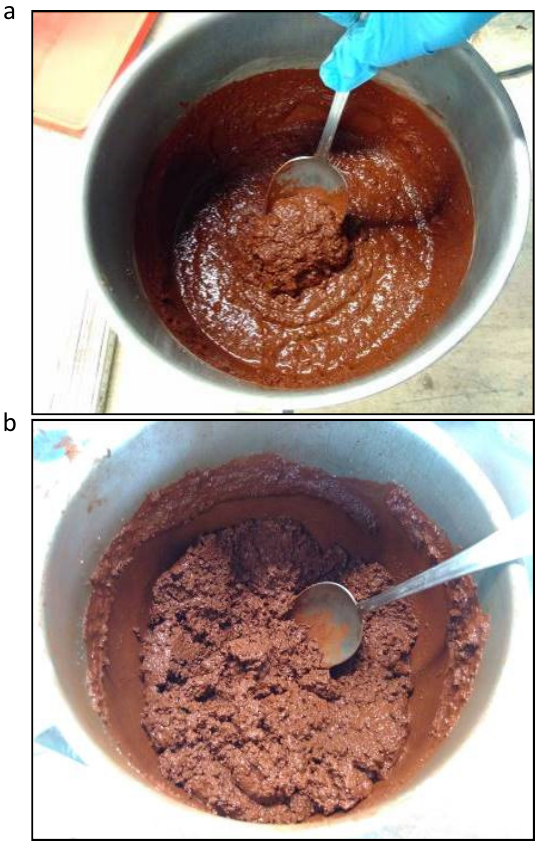
Table 2. Composition and consistency of GPM activator (waterglass, 35 wt.% water content) banahCEM 400 added water crushed sand 0/4 paste volume l/m³ 430 370 effective water/solid ‐ ratio ‐ 0.37 0.37 flow ‐ table spread (without jolts/with jolts) mm 132/165